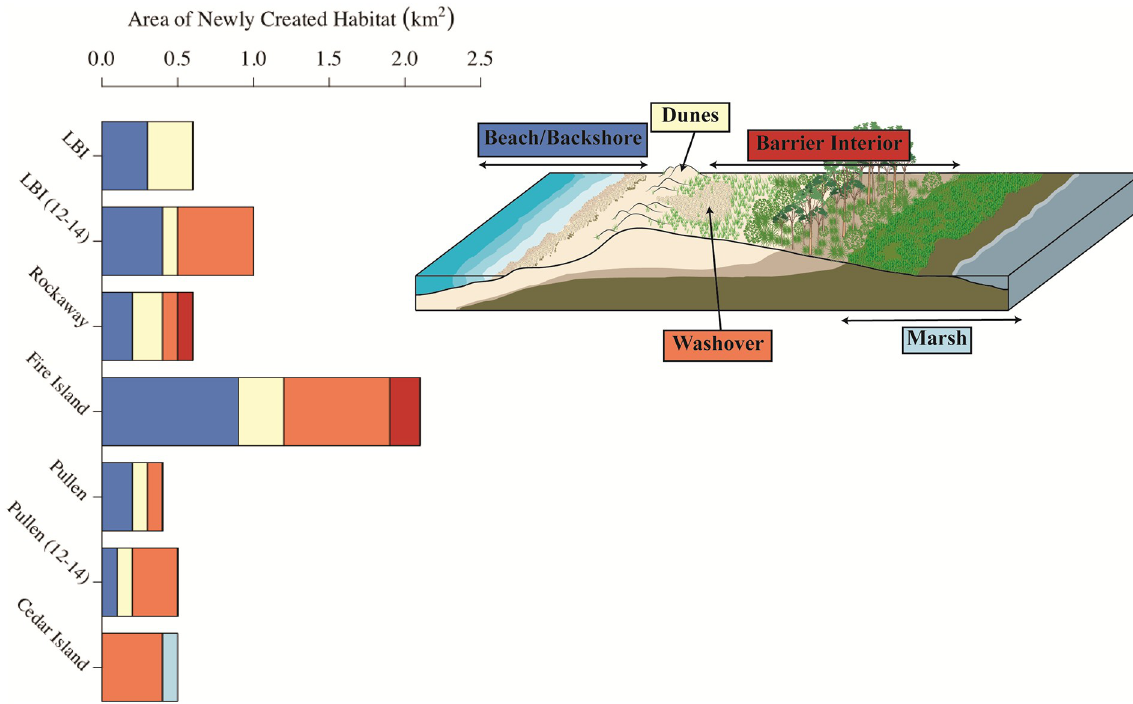
Fig 9. (a) Area of piping plover nesting habitat, according to predictions by the Plover Habitat Bayesian network, that was created immediately after Hurricane Sandy (i.e., newly created habitat between the pre- and post-Sandy periods). Bars showing habitat area are divided based on the geomorphic settings (defined in [34]) that were present after Hurricane Sandy according to October/November 2012 aerial photography and lidar. Because habitat continued to increase on Long Beach Island (LBI) and Pullen Island between the post- and ca. 2 years post-Sandy periods, we also include the amount and proportions of habitat created during that second time period for those sites (labeled with ‘12–14’ to denote the second period of habitat gain). Geomorphic settings for ‘12–14’ bars reflect settings available in the ca. post-Sandy period (June 2014). We combined the ‘beach’ and ‘backshore’ settings here for display purposes. Colors comprising bars in (a) are defined by colors of setting names in (b), and sites are listed from most to least